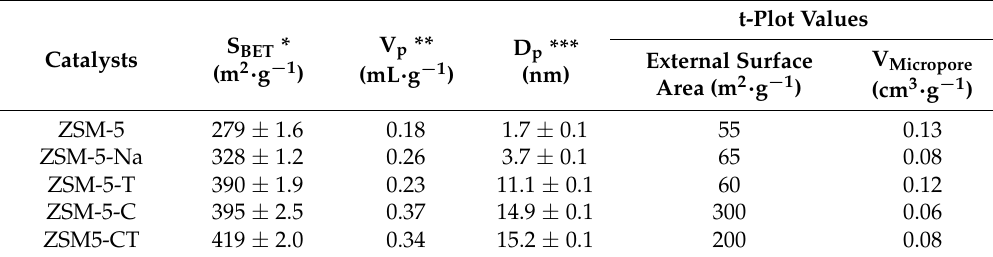
Table 3. N 2 adsorption-desorption isotherms of untreated and treated zeolites.